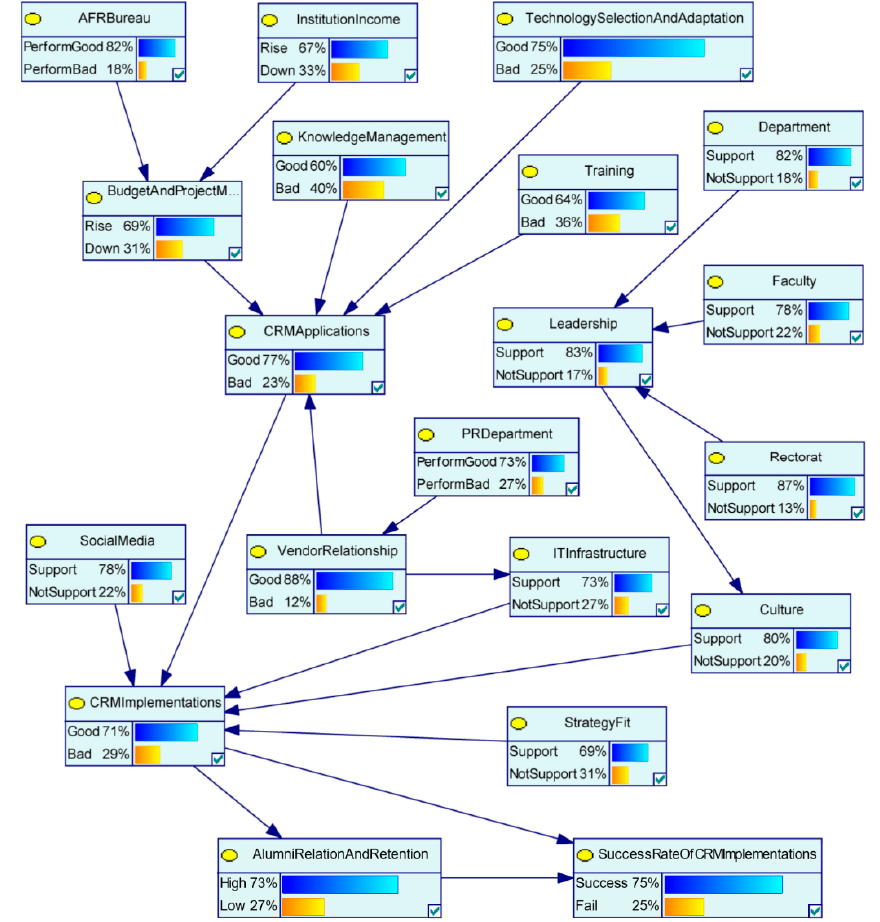
Figure 9. Social CRM: the result of running the program in the XDSL document.